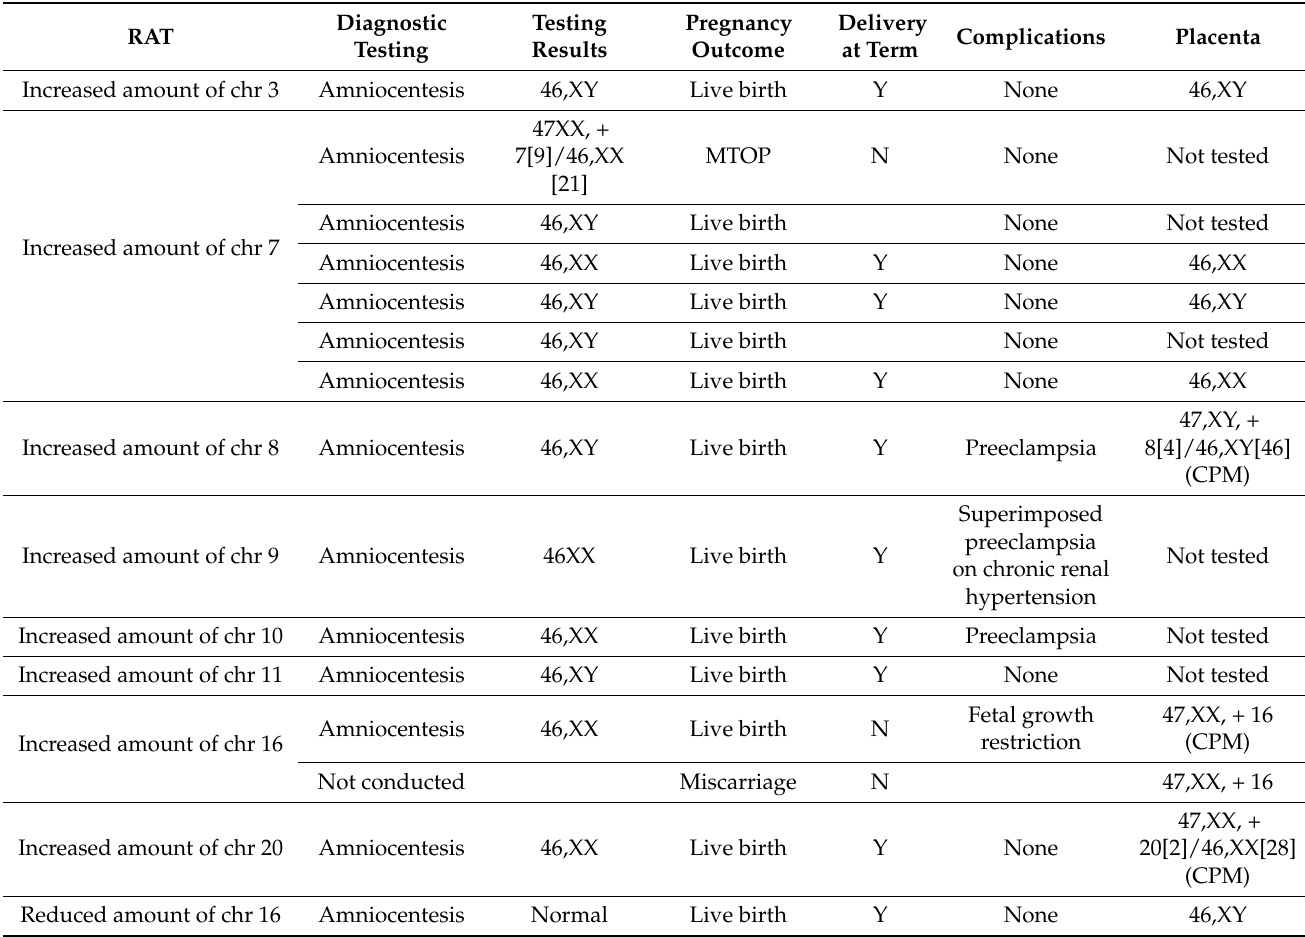
Table 2. Details of rare autosomal trisomy